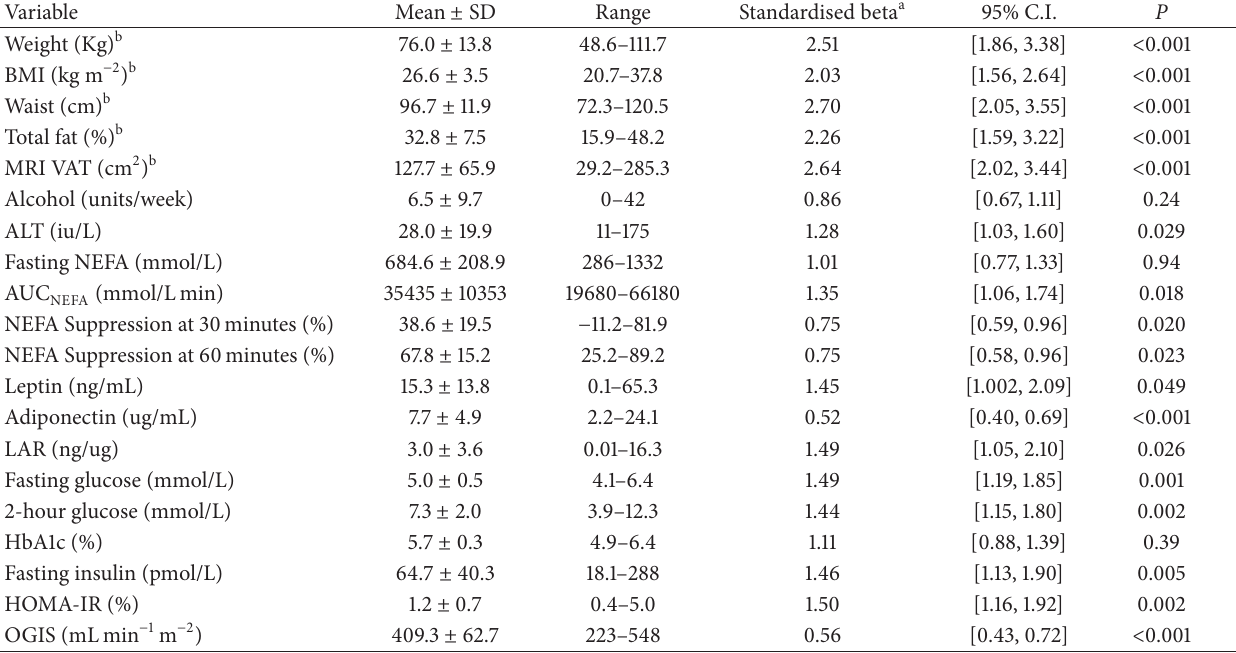
Table 1: Anthropometric and metabolic characteristics of study participants and their associations (after standardization) with intrahepatic lipid as the outcome measure.